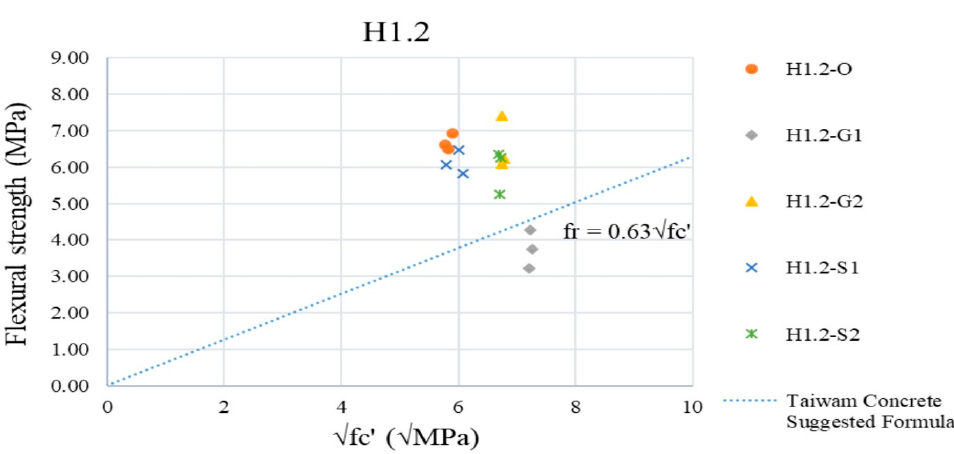
√ fc (cid:48) for H1.2 high-strength pervious